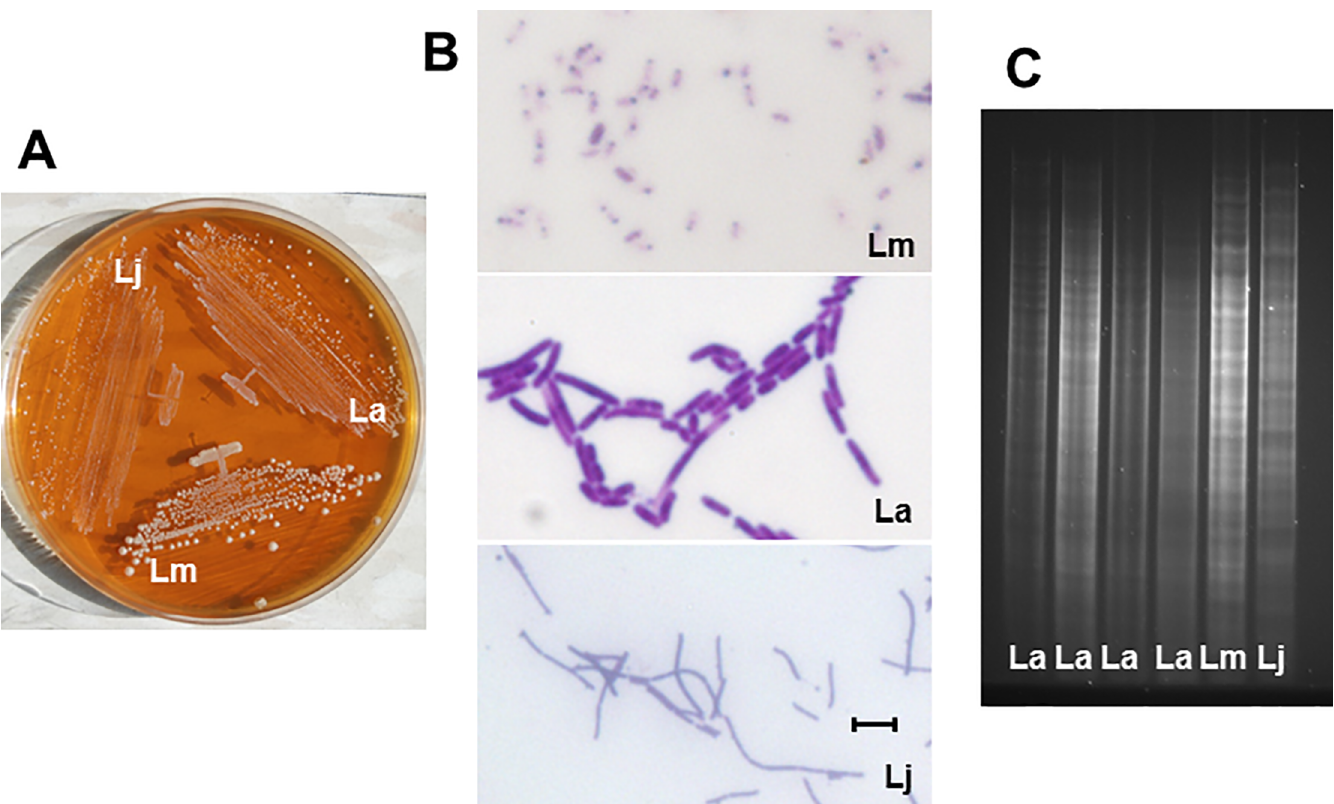
Fig 1. Distinguishing features of Lactobacillus strains. A, Colony appearance on MRS agar following 3 day incubation. Note opaque, glassy, and intermediate colonies of L . murinus , L . johnsonii , and L . acidophilus , respectively, as well as differences in colony size. B, microscopic images of Gram-stained bacteria. L . murinus , L . acidophilus , and L . johnsonii are short, stubby intermediate, and thin long noodle-like rods, respectively. C, Electropherograms of Hin dIII-digested DNA. Lm, L . murinus ; La, L . acidophilus ; Lj, L . johnsonii . Bar = 2 μ M.